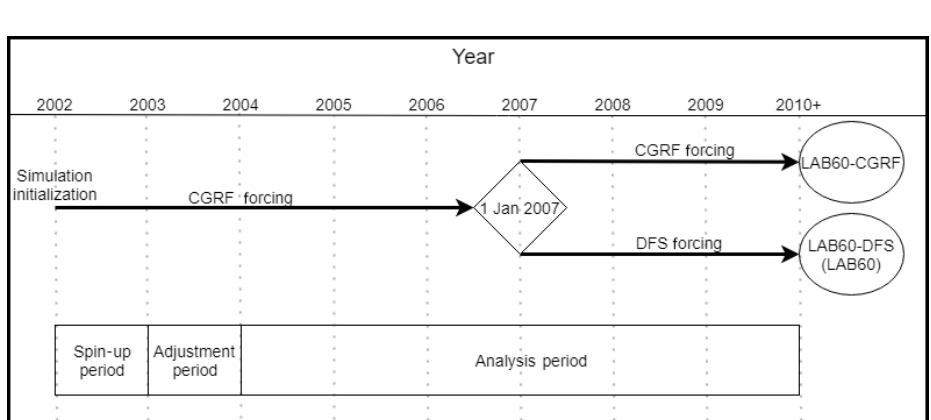
Figure 2. Diagram showing the multiple periods of the LAB60 simulation. The original simulation was initialized with CGRF atmospheric forcing in 2002, although a branch swapping to DFS occurred at the start of 2007. This DFS branch is what is primarily presented in this